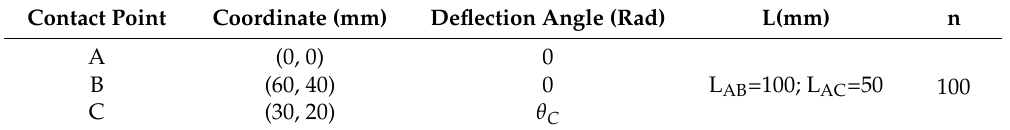
Table 2. Input data for the three-point contact guidewire deformation problem.